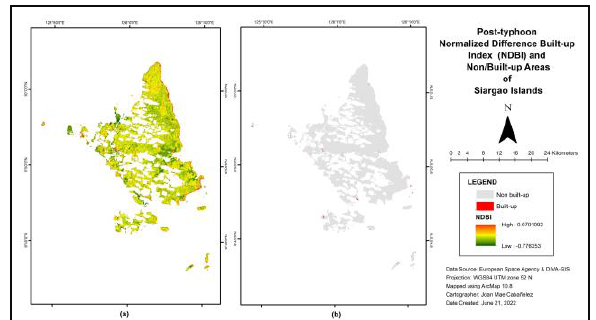
Figure 14 . NDBI and built-up layers of Siargao Islands during post-typhoon